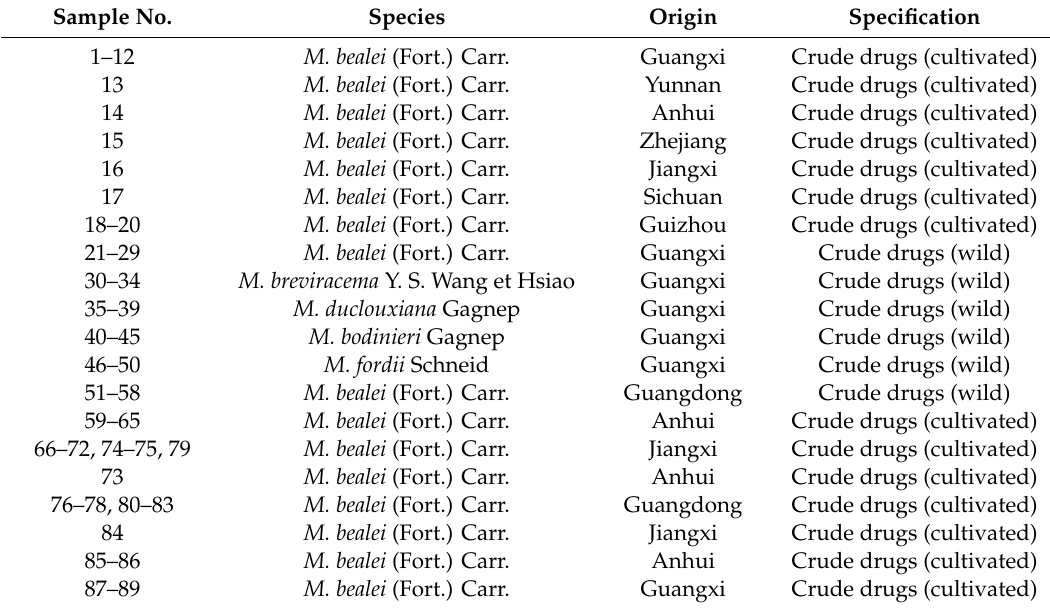
Table 3. Detailed information of